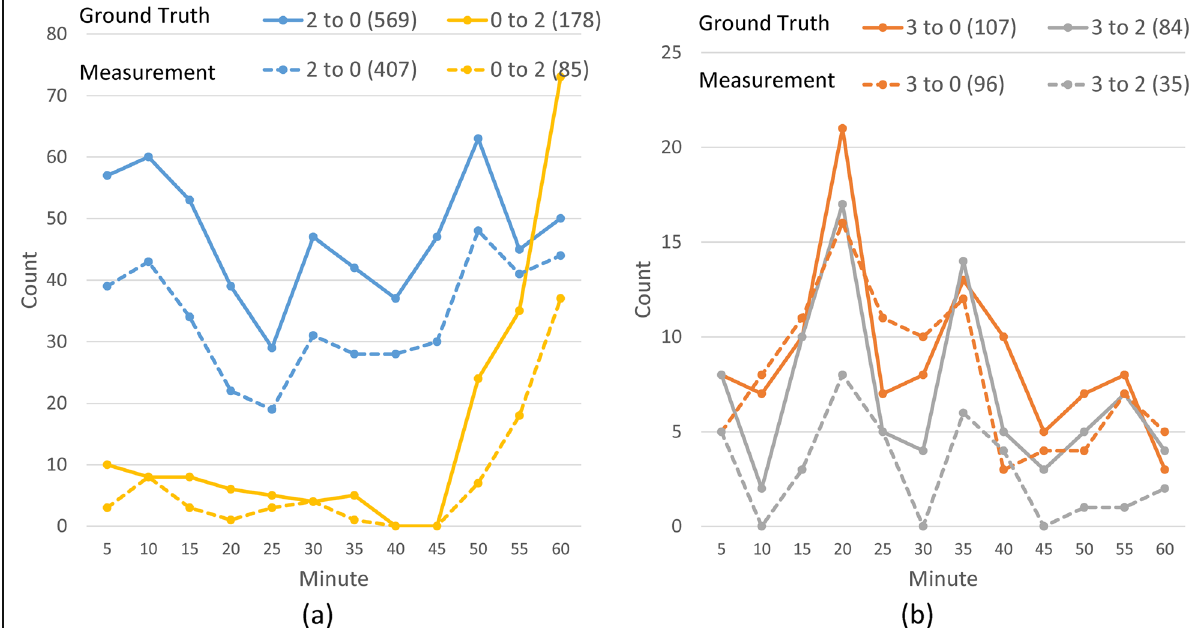
Fig. 10 Intersection turning pattern after the TAMU vs. Florida game. Legend: origin to destination edge (total count). Solid lines represent the ground truth with 5 min interval, and dash lines indicate the